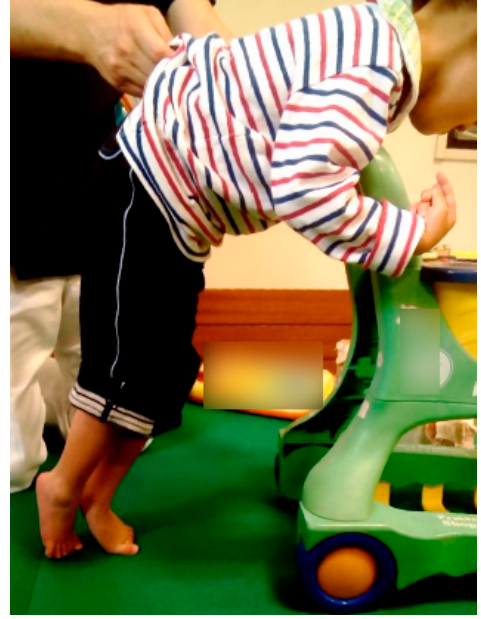
Figure 1. Standing posture of the case patient at age 4 years.